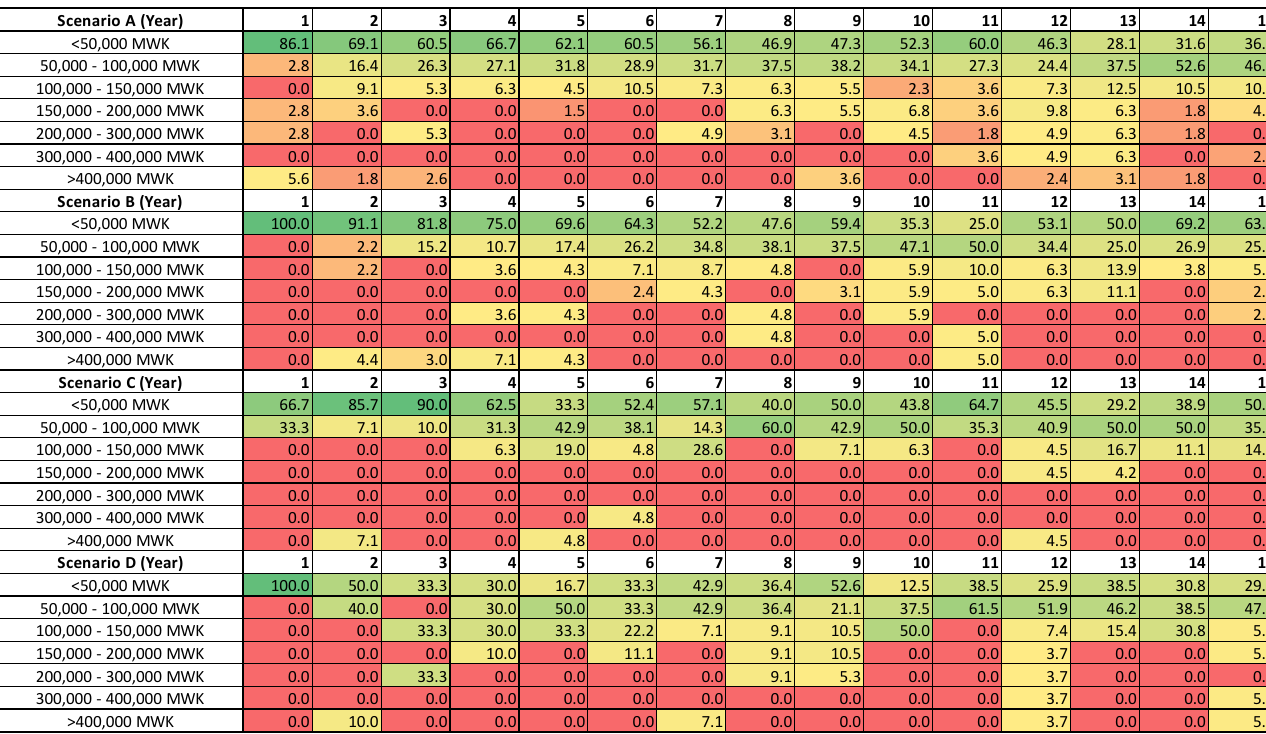
Figure 2. Heat map showing the percentage of total major repairs according to costs within each scenario for assets with no rehabilitation.